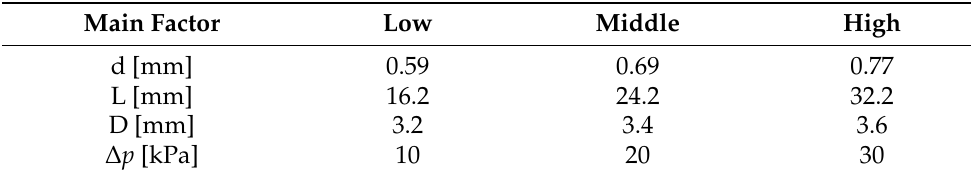
Table 1. Factors and levels for the DOE